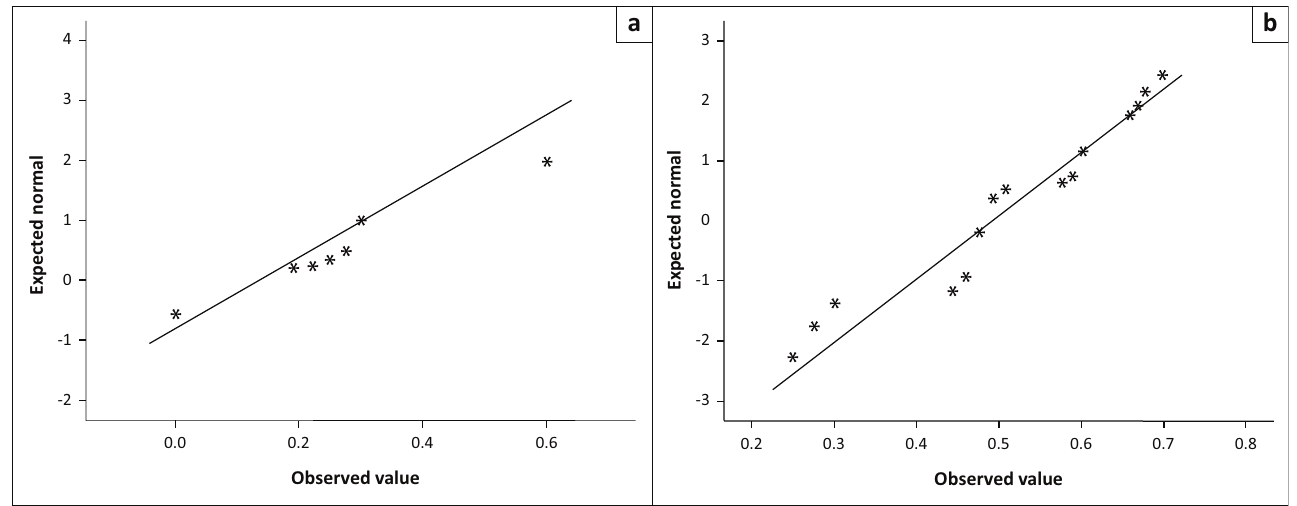
FIGURE 4: (a & b) Normalised plots for ecosystem services provision (wet resource state and dry resource state). TABLE 6: Regression coefficients. Season Target layer Independent study variable